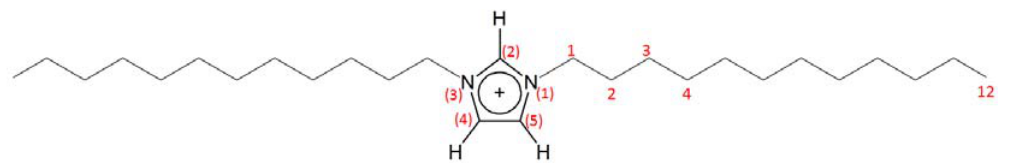
Scheme 1. The structure and labelling schema of the C 12 C 12 im cation.